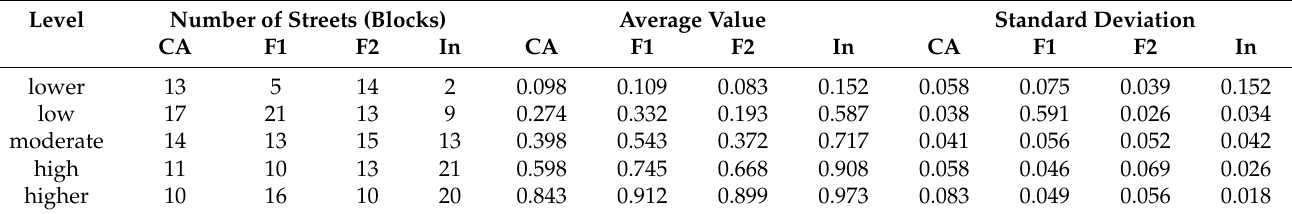
Table 9. Statistics of green space supply in urban areas of